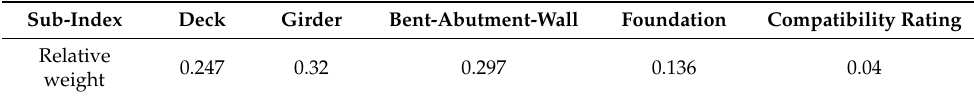
Table 9. Relative weight of sub-indices in structural index (Results of Expert Choice software).